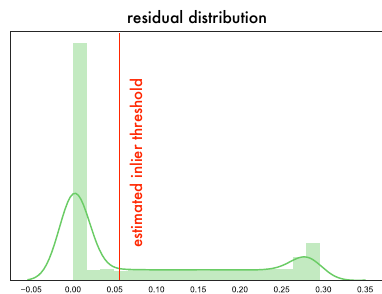
Figure 3. The distribution of the residuals computed w.r.t. the paraboloid estimated from LMedS on the toy example of Figure 2, together with the inlier threshold (red line) obtained via For- ward Search.